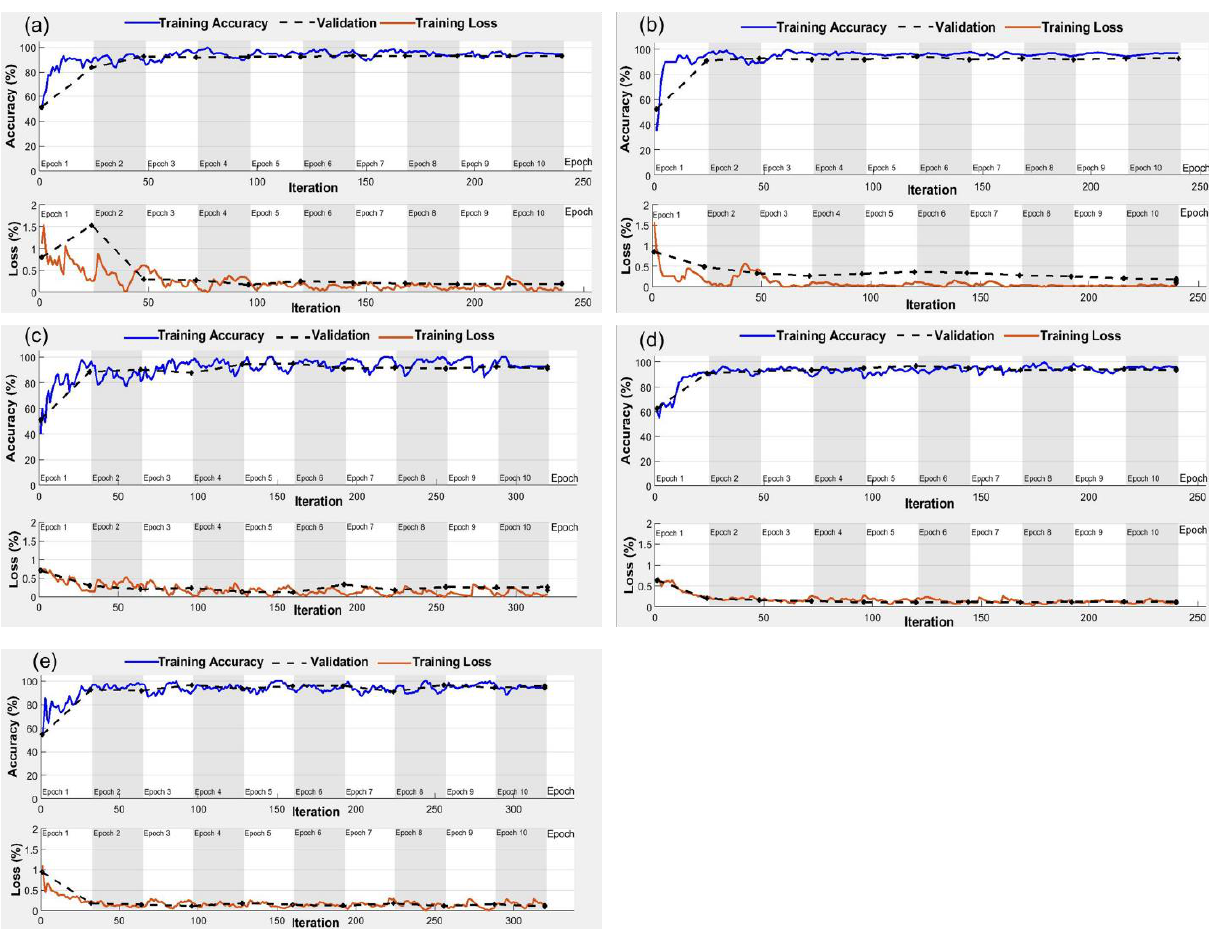
Figure 5. Accuracy and loss curves for ( a ) AlexNet; ( b ) GoogLeNet; ( c ) Inception V3; ( d ) MobileNet V2; and ( e ) ResNet50 models with RGB imagery inputs for crop water stress identification. The training time elapsed for AlexNet, GoogLeNet, Inception V3, MobileNet V2, and ResNet50 was 76, 92, 609, 149, and 217 min with RGB imagery inputs, and 42, 88, 287, 134, 168 min with thermal imagery inputs, respectively. While the classification of an independent image using trained models into stressed/non-stressed class consumed less than 5 s. The overall validation accuracies (combined for stressed and non-stressed classes) for AlexNet, GoogLeNet, Inception V3, MobileNet V2, and ResNet50 models were 93.4%, 95.9%, 92.5%, 94.4%, and 96.9%, respectively with RGB imagery inputs (Figure 7). The highest precision (100%) and F1 score (96.6%) were observed for GoogLeNet and ResNet50, respectively while maximum sensitivity was achieved for MobileNet V2 (Table 6). Pertinent to thermal imagery inputs, overall validation accuracies (combined for stressed and non- stressed classes) with AlexNet, GoogLeNet, Inception V3, MobileNet V2, and ResNet50 models were 96.2%, 96.9%, 97.5%, 94.7%, and 98.4%, respectively. Alike RGB imagery, ResNet50 for thermal imagery had the highest precision (96.7%), sensitivity (100%), and F1 score (98.3%) (Table 6). Additionally, the accuracies were higher for the models with thermal imagery inputs compared to those with RGB imagery inputs. The individual accuracy and errors for all the feature extraction-based models with validation datasets are shown in Figure 7. The mean errors were higher for the RGB imagery compared to the thermal imagery irrespective of the selected